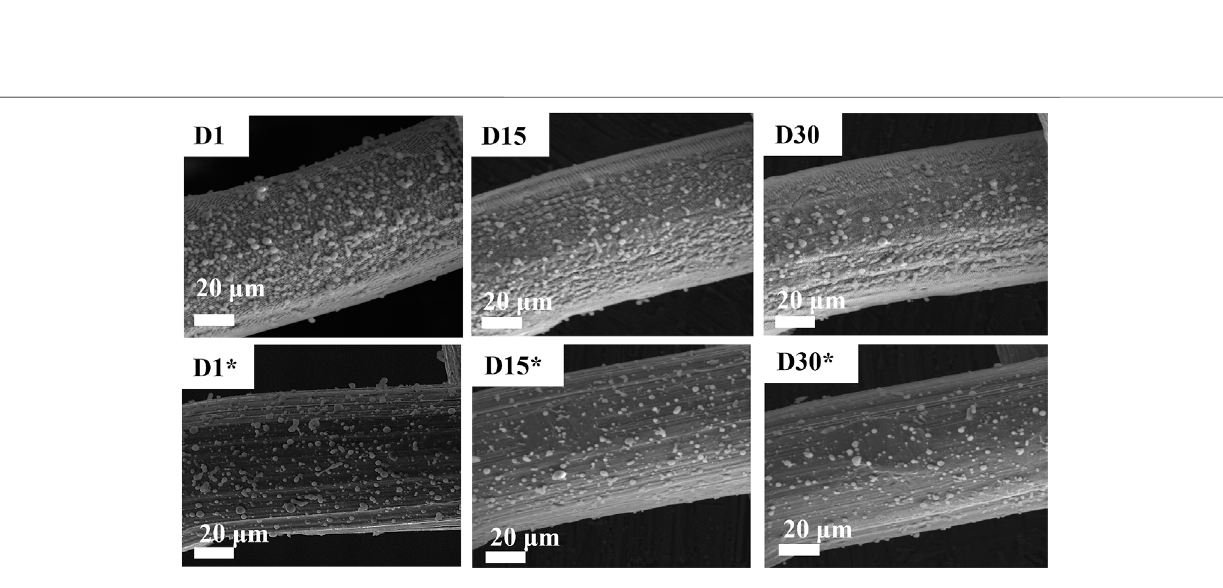
Frontiers in Chemistry |